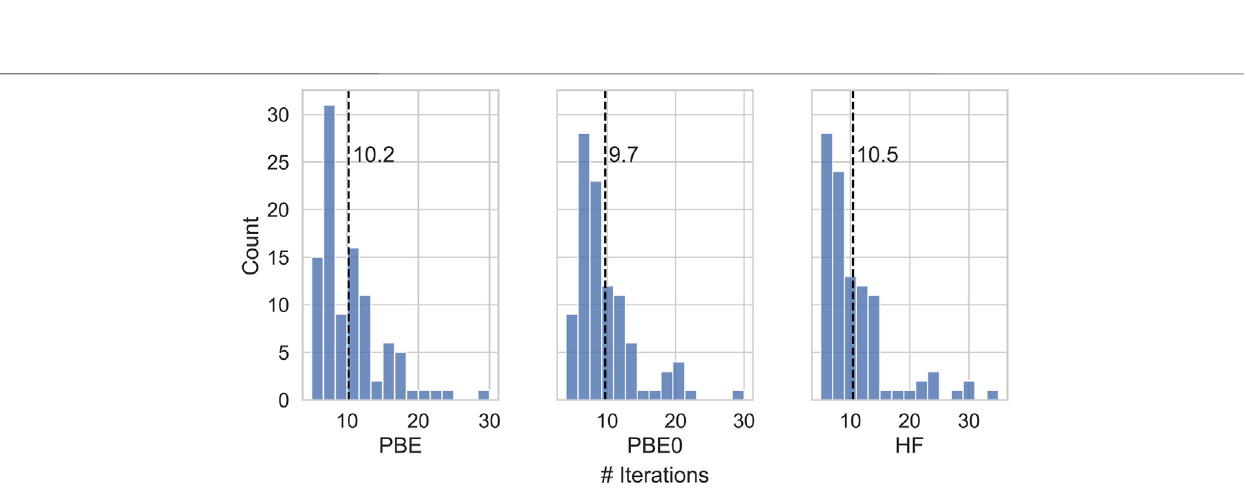
FIGURE 3 | Number of iterations needed to attain convergence of the SCF for different initial guesses.